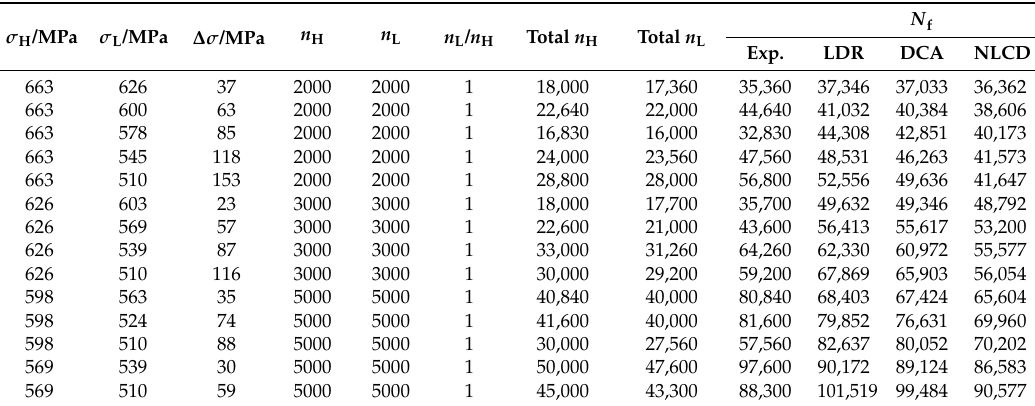
Table 3. Test results under the two-level repeated loading with n L / n H =